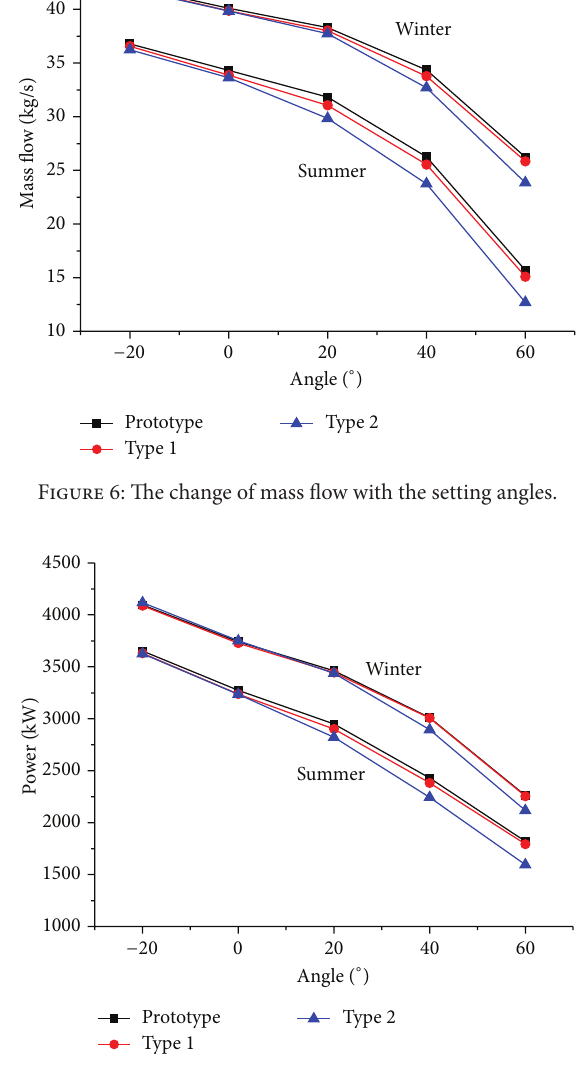
Figure 7: The change of power with the setting